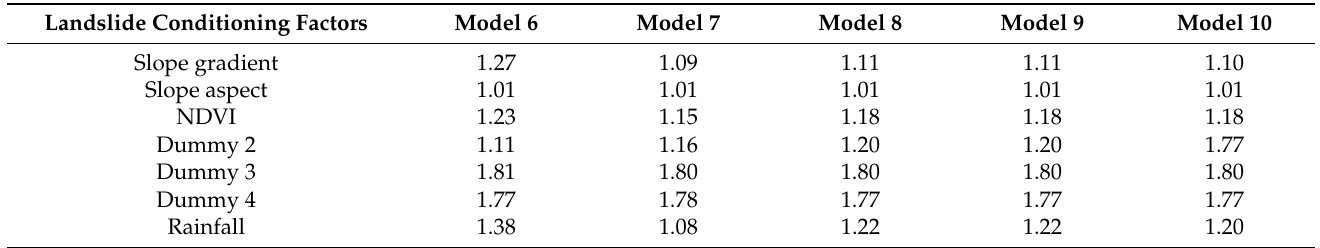
Table A5. Variance inflation factors (VIF) for the five models (i.e., models